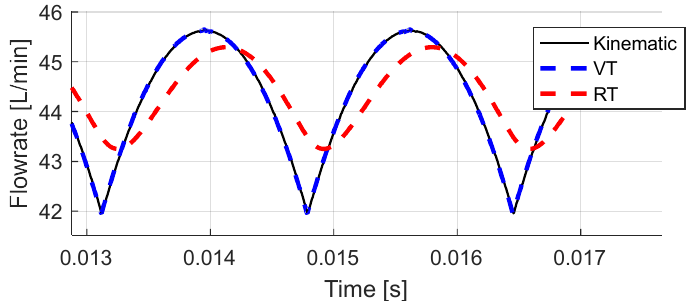
Figure 20: The change of kinematic ripple under 2000 RPM 200 bar condition for the volume- The change of kinematic ripple under 2000 RPM 200 bar condition for the termination circuit (VT) and for the restriction-termination circuit (RT). volume-termination circuit (VT) and for the restriction-termination circuit (RT).